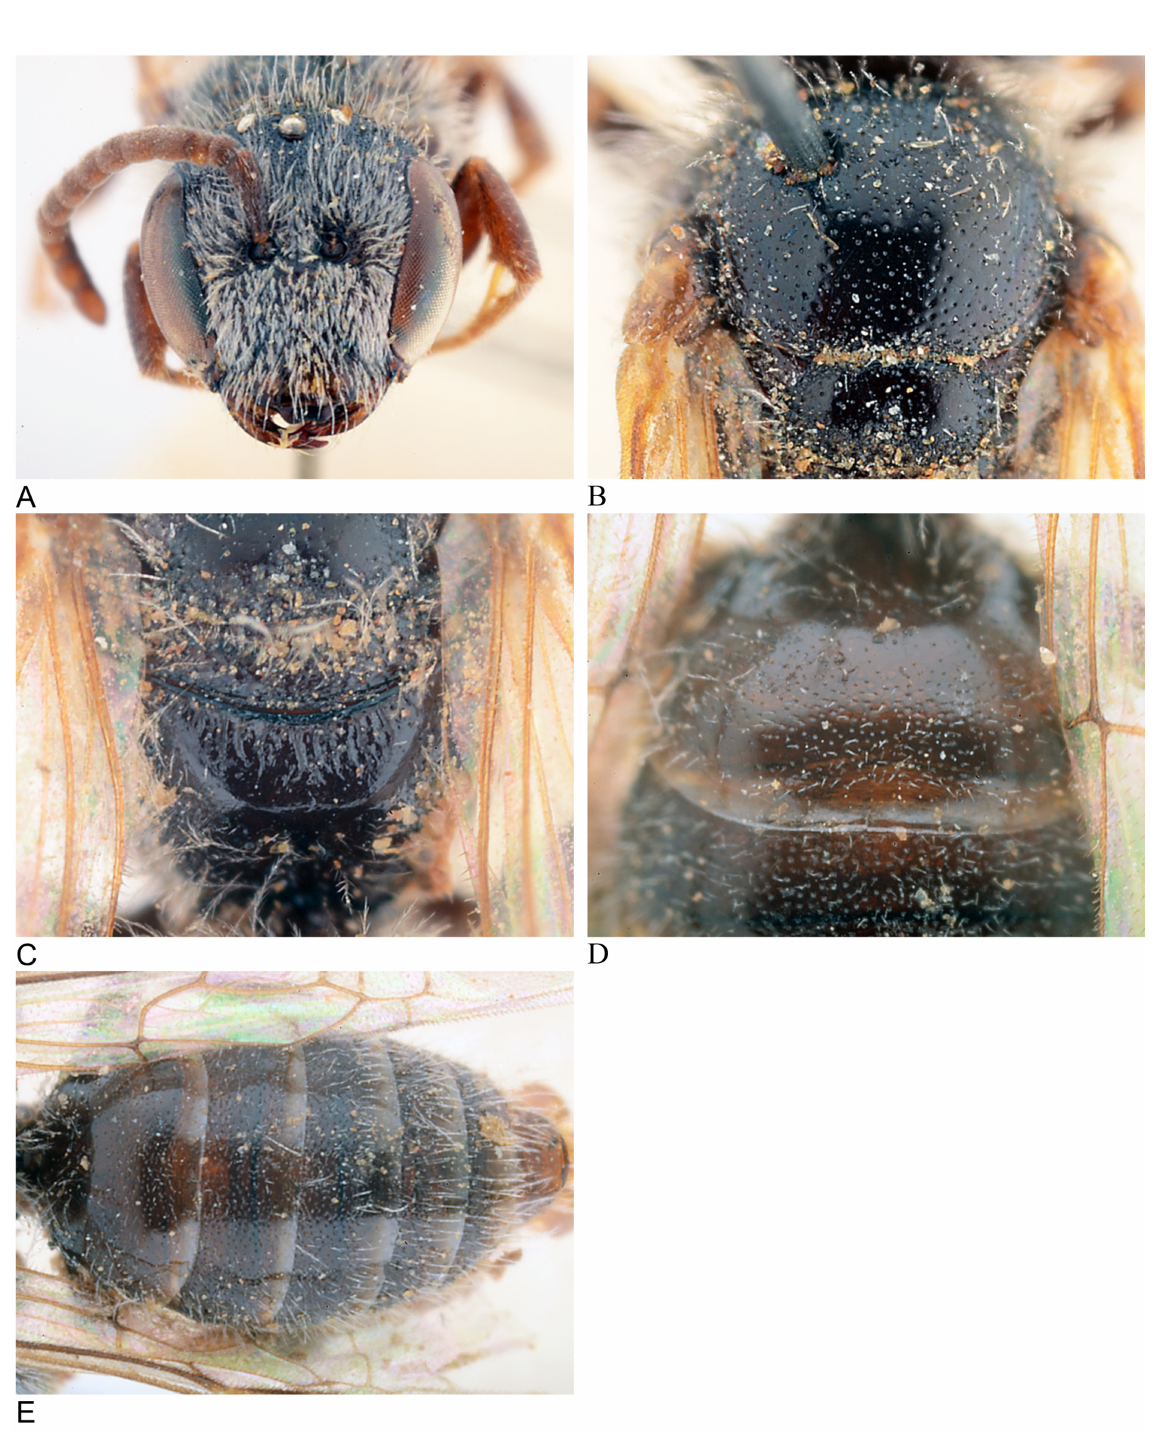
Fig. 23. Lasioglossum berberum (Benoist, 1941), holotype, ♂. A . Head. B . Scutum. C . Propodeum. D . First tergum. E .